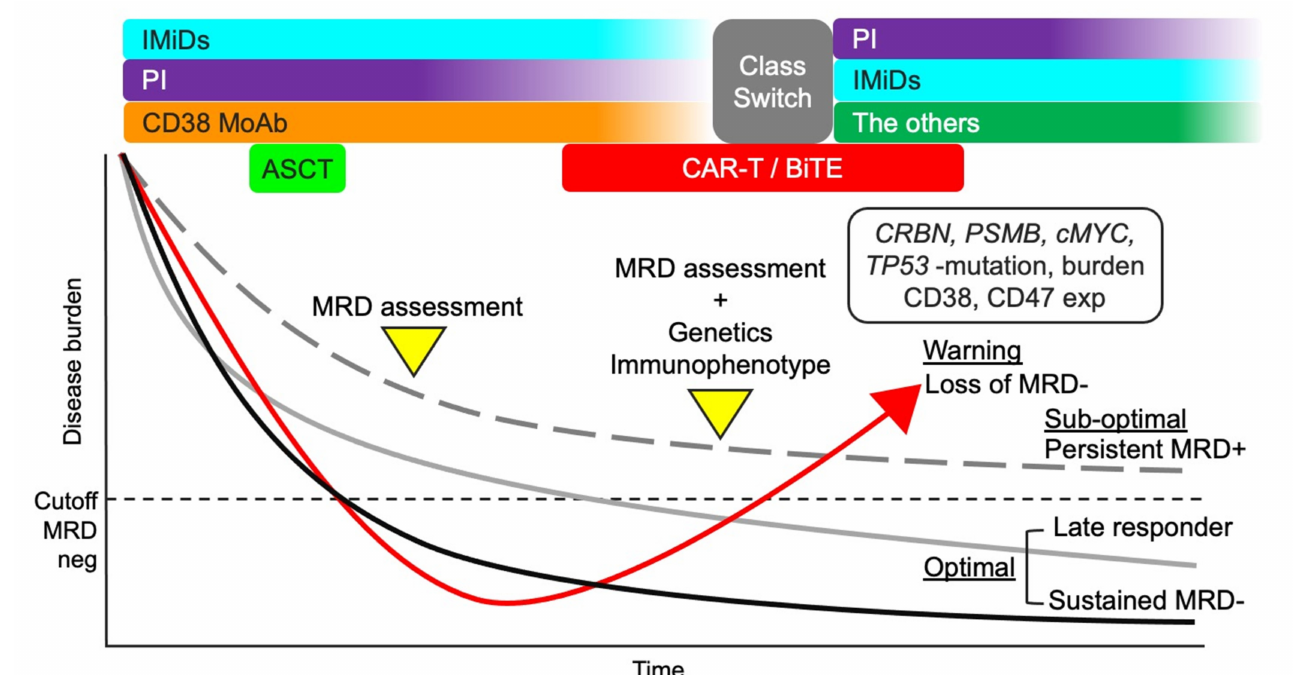
Figure 3. Treatment strategy considering MRD status. A total therapy approach combining IMiDs, PIs, anti-CD38 MoAb, and ASCT may be suitable for MM patients considering the efficacy against myeloma cells and improved microenvironment. MRD status after the total therapy approach can be useful in further treatment decisions. If the MRD status is negative, the current treatment should continue (optimal). However, if the MRD status is positive, the genetic and immunophenotypic characteristics of residual myeloma cells should be analyzed to optimize treatment. Loss of MRD negativity can lead to aggressive recurrence (warning). The clinical outcome of persistent MRD positivity is better than that of loss of MRD- negativity (sub-optimal). Repeated MRD assessment may be necessary for patients with persistent MRD positivity to identify late responders and detect early-phase recurrence. MM, multiple myeloma; MRD, minimal residual disease; IMiDs, immunomodulatory drugs; PIs, proteasome inhibitors; MoAbs, monoclonal antibodies; ASCT, autologous stem cell transplantation; CAR-T, chimeric antigen receptor T cell; CRBN, cereblon; PSMB5, proteasome 20S subunit beta 5; and exp,